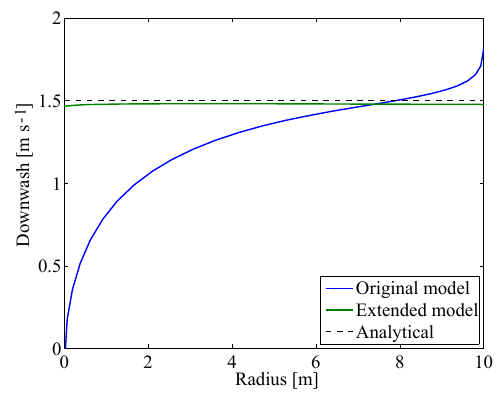
Figure 3. Results for an elliptical